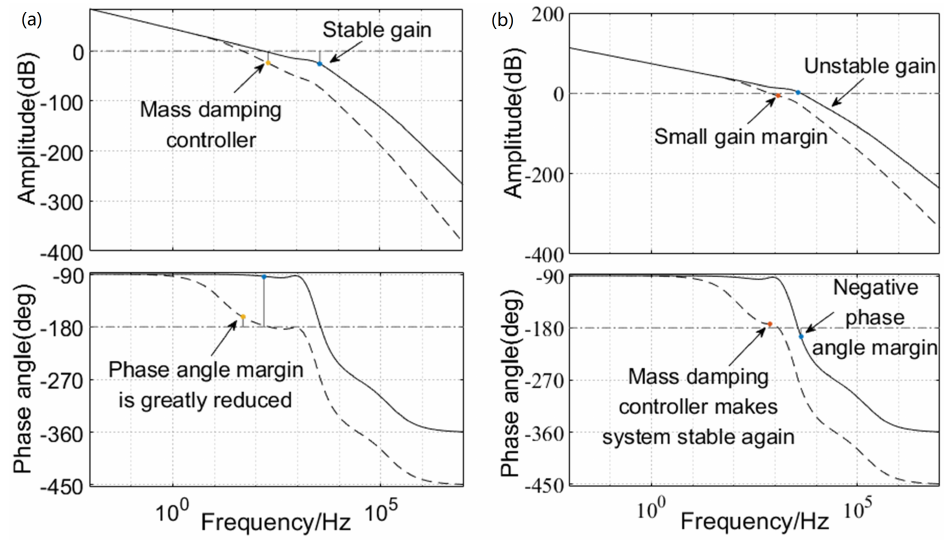
Figure 13. Analysis of the introduction of mass damping controller. ( a ) Stable gain introduces mass dampling controller; ( b ) Unstable gain introduces mass dampling